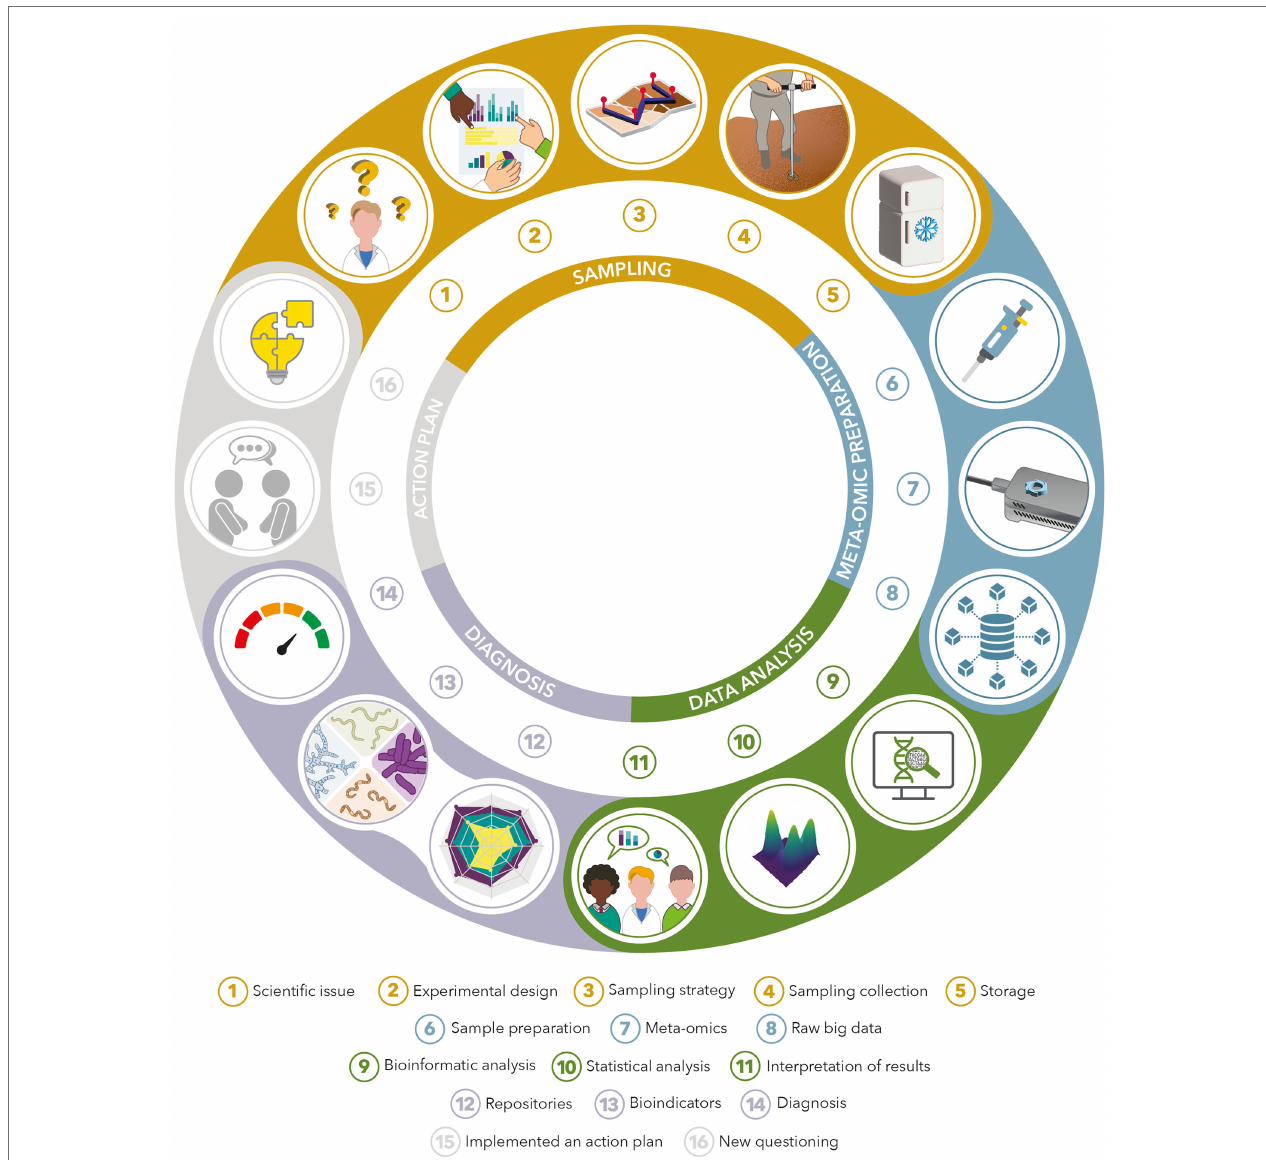
FIGURE 6 | Example of a strategy for studying soil samples with meta-omics approaches: from basic research issues to operational